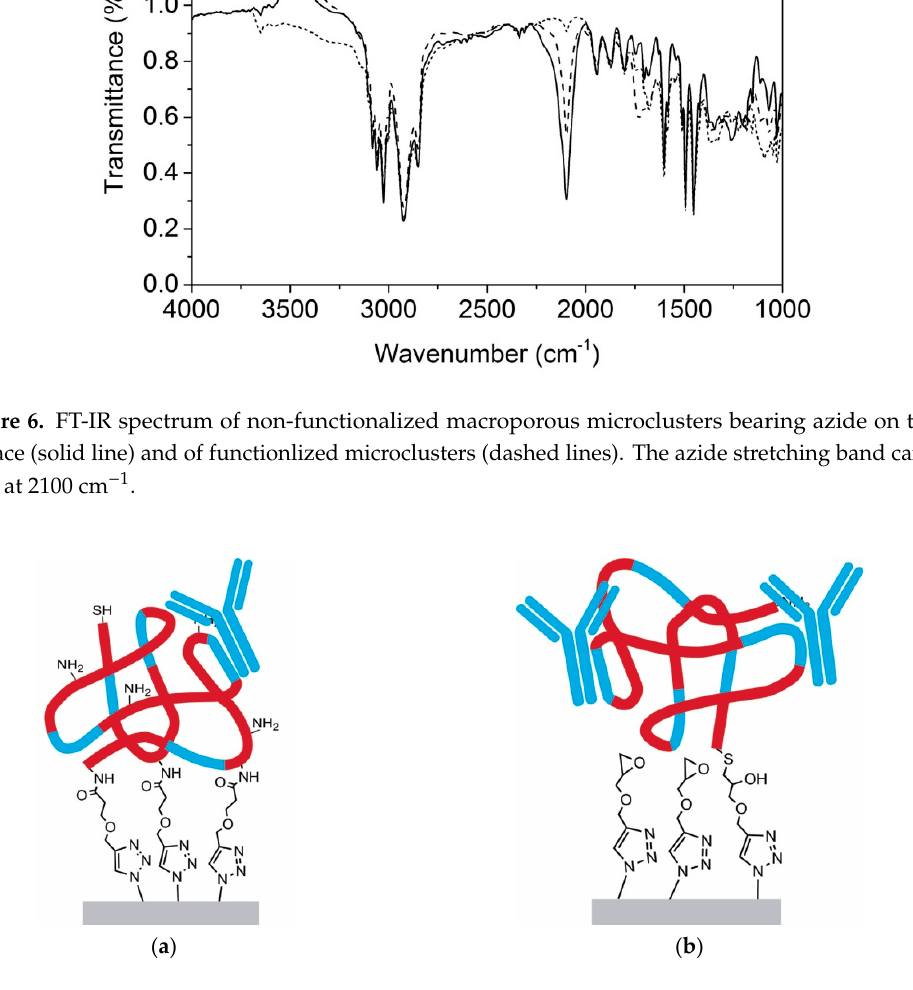
Figure 6. FT-IR spectrum of non-functionalized macroporous microclusters bearing azide on their surface (solid line) and of functionlized microclusters (dashed lines). The azide stretching band can be seen at 2100 cm − 1 .